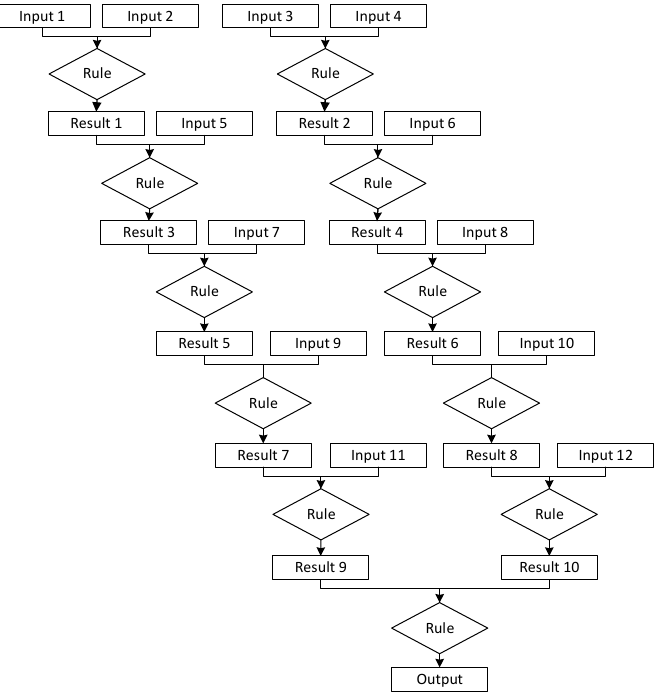
Figure 3. Logical design of Network 3.